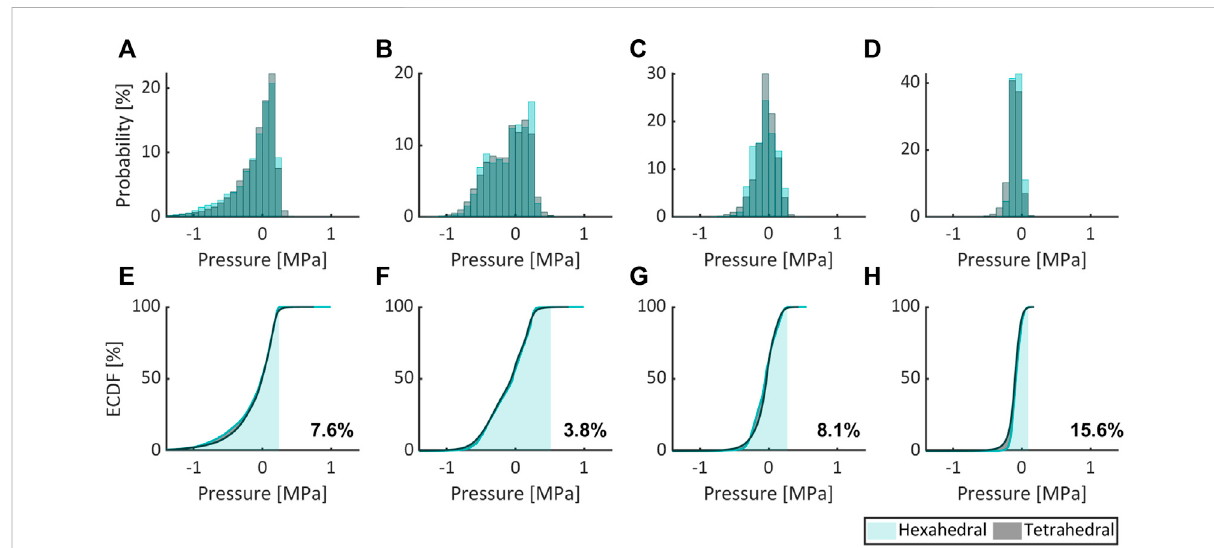
FIGURE 5 Comparingthemechanicalpressureexpressedasprobability(normalizedhistogram)andECDFfor fl exion (A,E) ,extension (B,F) ,lateralbending (C,G) , and axial rotation (D,H) for HE and TE types.